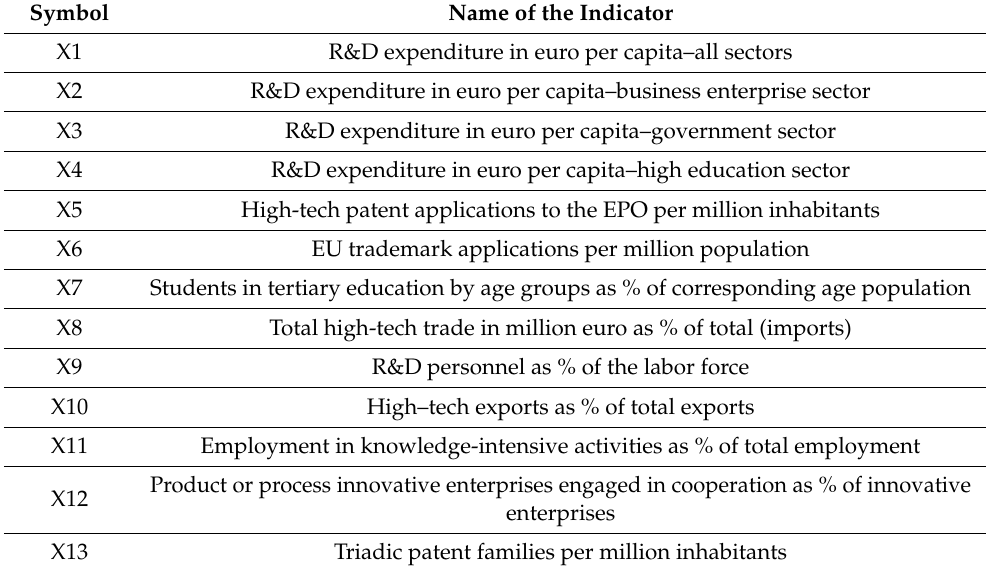
Table 3. A set of potential diagnostic indicators of